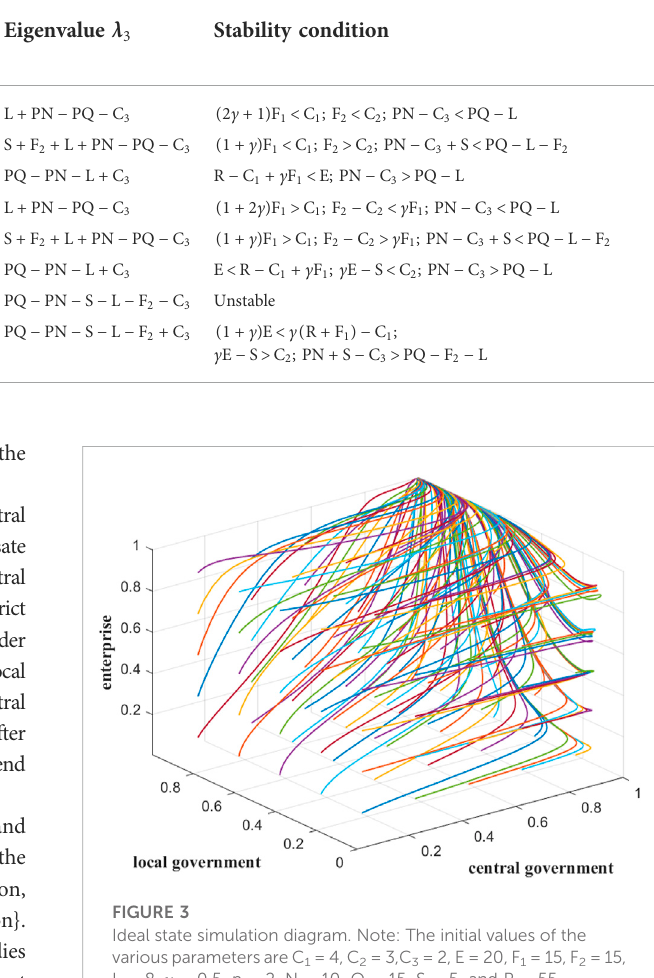
TABLE 2 Equilibrium point and stability conditions of the system.